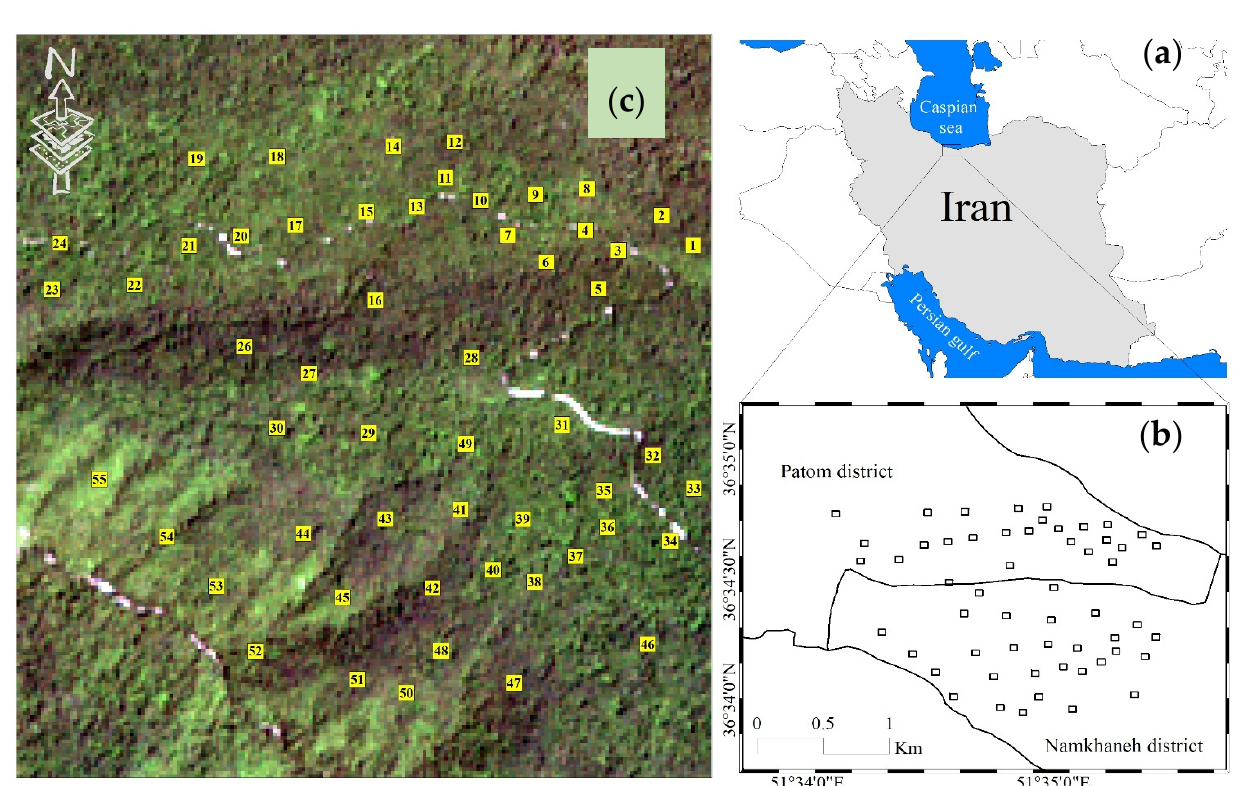
Figure A1. Map of Iran ( a ); location of sample plots in Patom and Namkhaneh district ( b ); location of sample plots over the Sentiel-2 image ( c ). Table A1. Number of trees, mean value of DBH, volume, and AGB estimation per sample plot. Plot No.